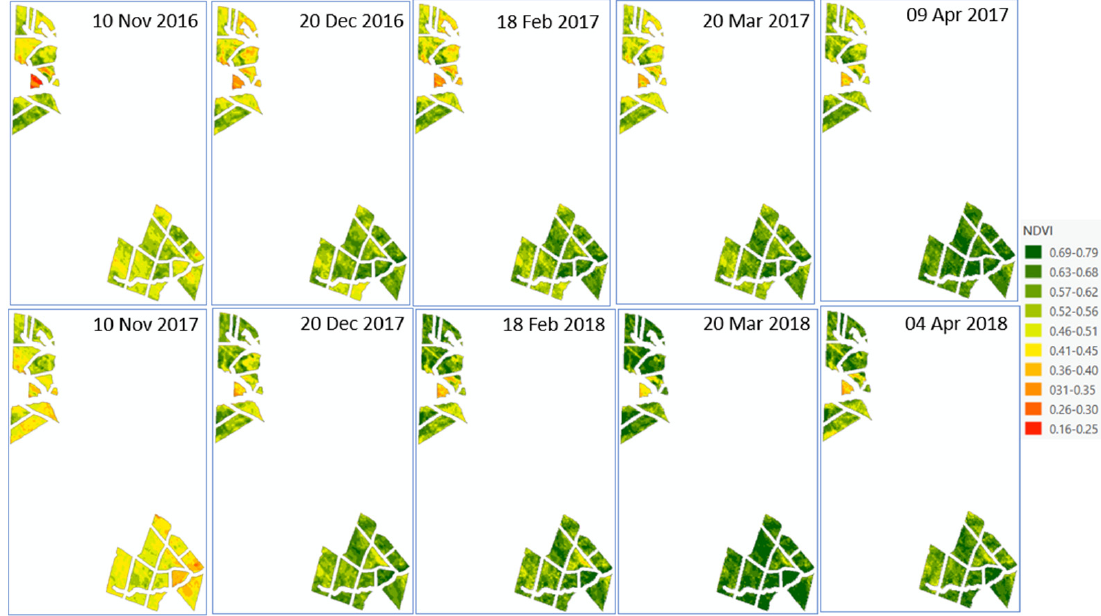
Figure 5. Representation of NDVI (Normalized Difference Vegetation Index) maps from blooming to harvest for the 2017 ( upper row ) and 2018 ( lower row ) seasons. Color scale of 10 unique ranges for all dates.